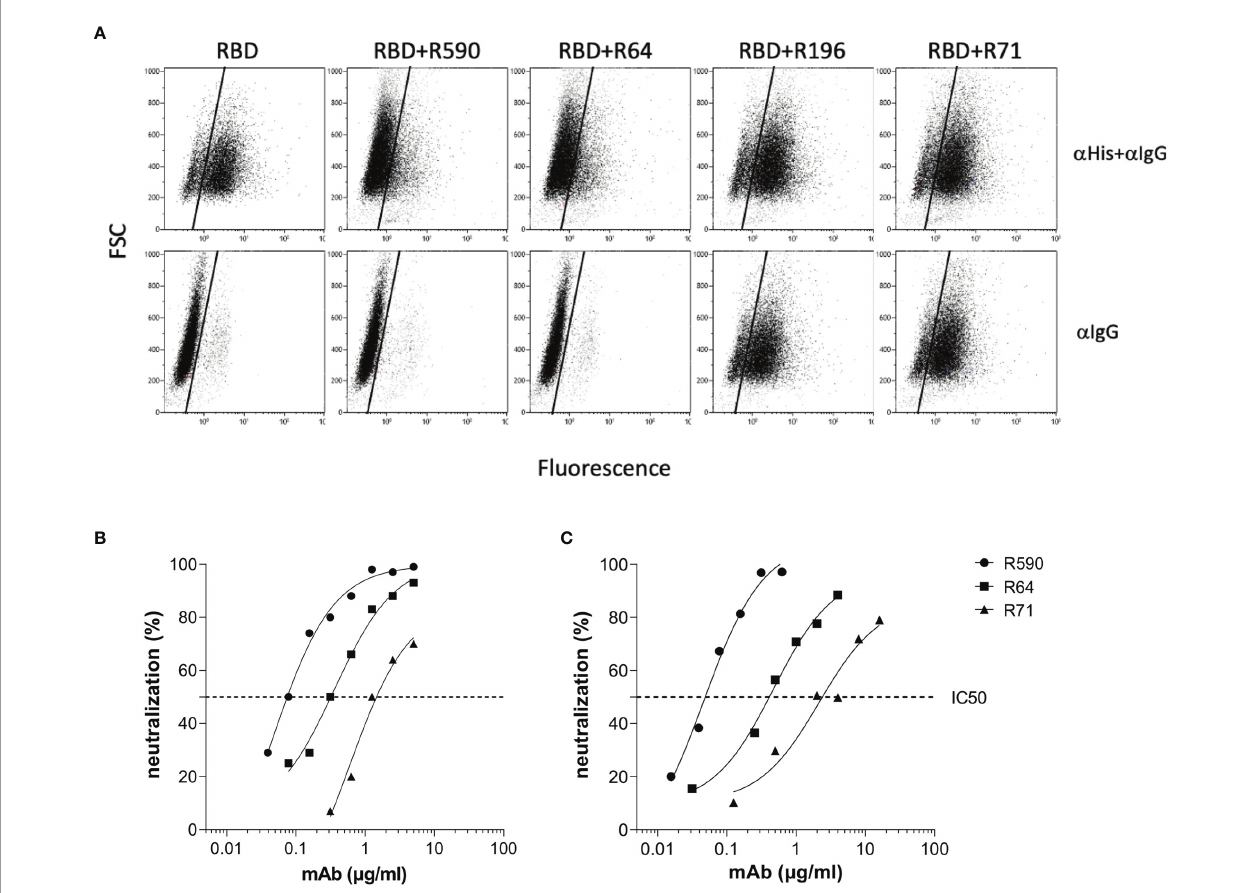
FIGURE 4 | mAb inhibition of RBD-ACE2 binding and neutralization activity against Wuhan SARS-CoV-2. (A) B16-hACE2 cells were incubated with rRBD alone or with rRBD pre-incubated with isolated mAbs. In the upper panels the ACE2-RBD binding was quanti fi ed by measuring the signal given by an a -His mAb revealed with a FITC-conjugated a -mouse IgG mAb ( a His+ a IgG). In the lower panels, after rRBD incubation, an a -mouse IgG FITC-conjugated mAb was added in order to reveal anti-RBD mAbs bound to the hACE2 receptor. A representative experiment of two is shown. (B) Neutralization curves of anti-RBD mAbs against SARS-CoV-2 by PRNT or (C) spike pseudotyped LV neutralization assay. Data are representative of one experiment out of three with two technical